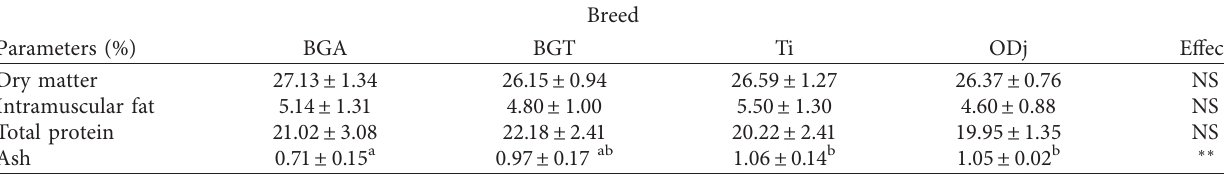
Table 2: Proximate composition of Beni-Guil, Timahdite, and Ouled-Djellal sheep meats. Breed